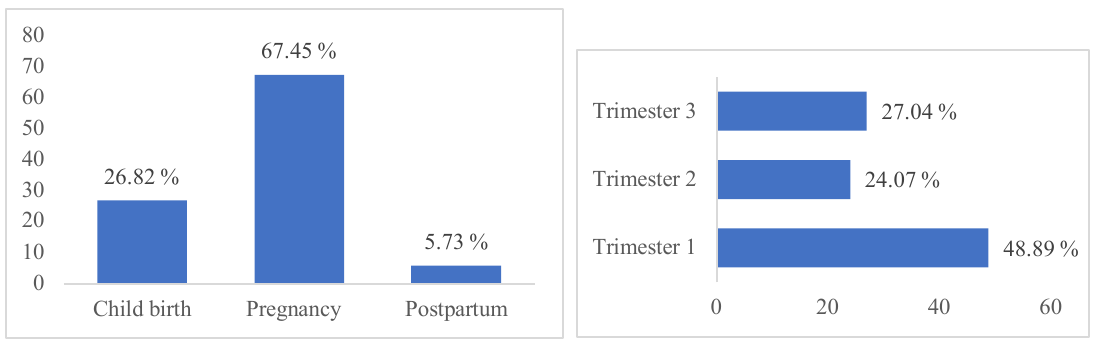
Figure 2. Prevalence of MP usage during pregnancy (Trimester 1, 2 and 3) at childbirth and at post- partum.